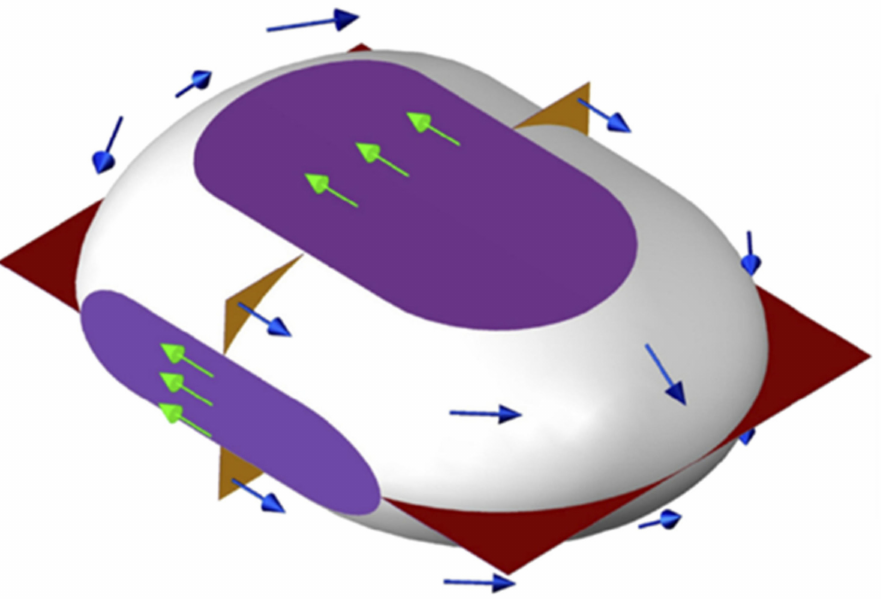
Figure 1. Flow patterns/stresses on the surface of drop moving in a rectangular channel. Reprinted from a study by Li et al. [28]. Copyright 2020, with permission from AIP